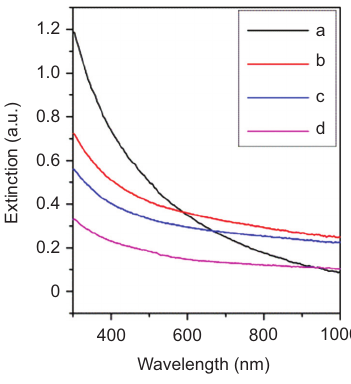
Figure 7 The UV/Vis spectra of the collected fractions.